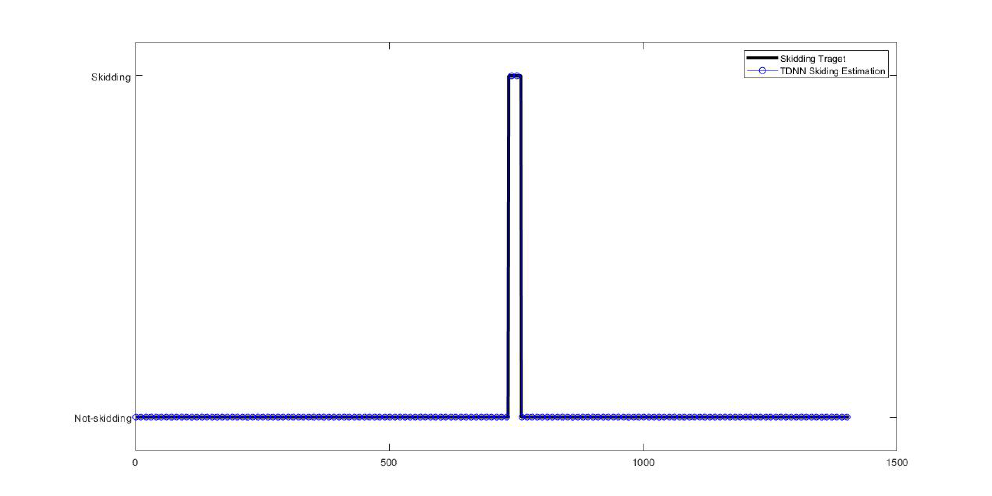
Figure 9. Results of skidding event classification for run 1 of the real world